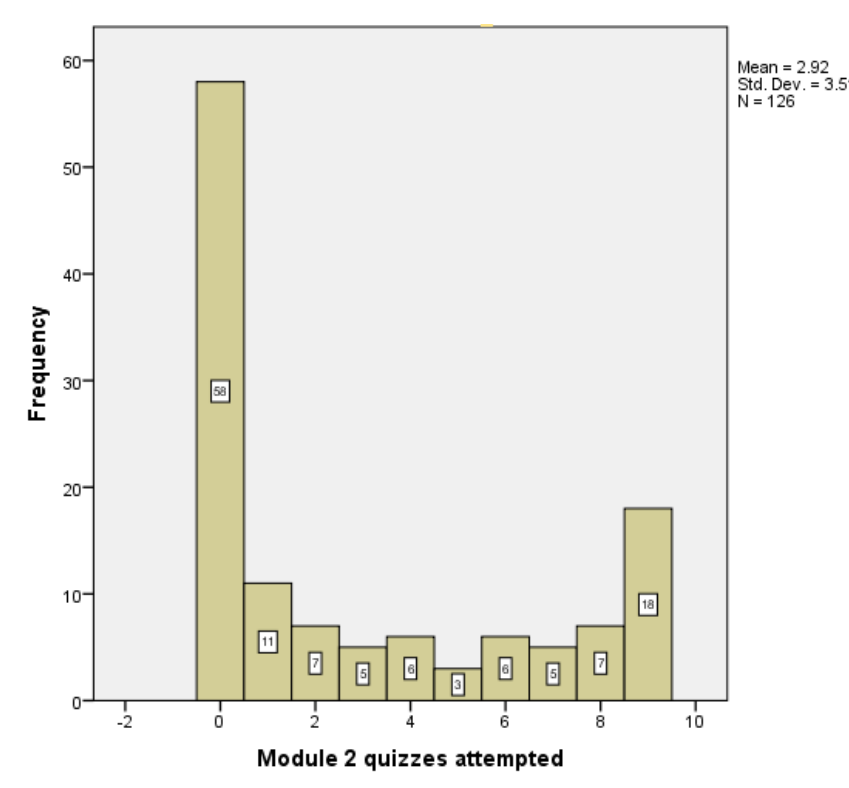
Figure 2: Distribution of task completions in Module 1